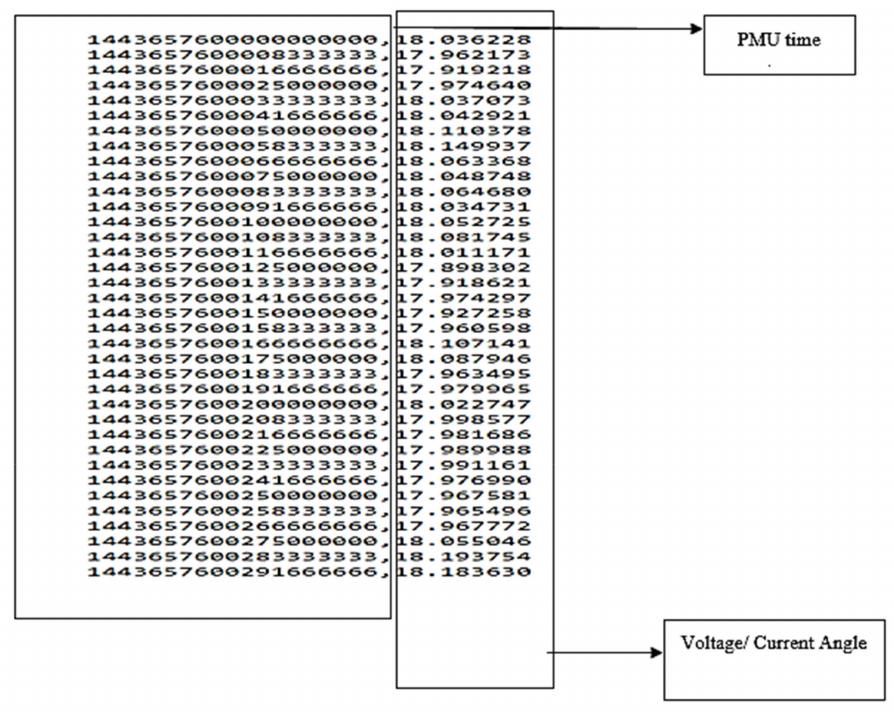
Figure 4. The Micro-PMU real data.